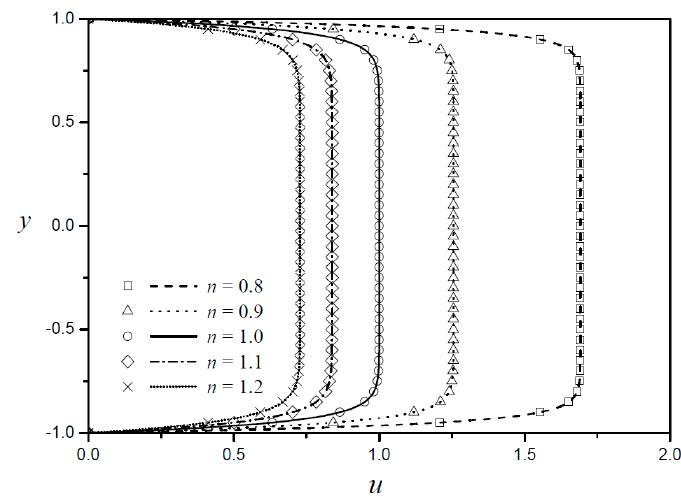
Figure 2. Velocity profiles obtained by the present result and numerical analysis for five different fluid behavior indexes for L D = 0.05 and Z R = 1.